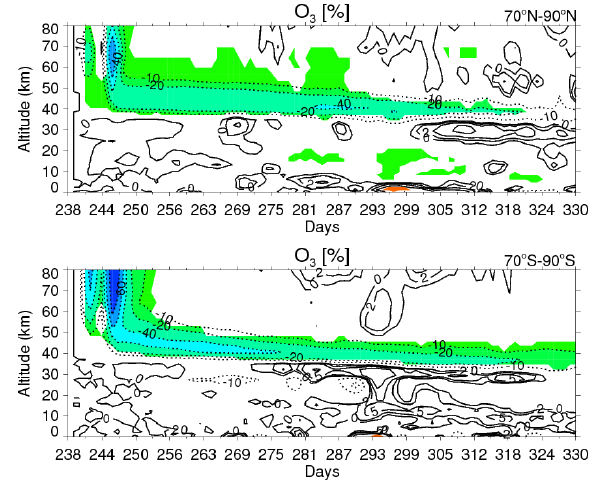
444 Fig. 4: Upper panel : Evolution of changes in ozone zonal mean mixing ratio profile in the polar 445 Fig. 4. Upper panel: evolution of changes in ozone zonal mean mix- region (70°-90°N) in percent. Lower panel : same for 70°-90°S. Colors indicate areas with at least 446 ing ratio profile in the polar region (70–90 ◦ N) in percent. Lower 95 % statistical significance. Contour levels: -100, -80, -60, -40, -20, -10, 0, 2, 5, 10, 50 %. 447 panel: same for 70–90 ◦ S. Colors indicate areas with at least 95% statistical significance. Contour levels: − 100, − 80, − 60, − 40, − 20, − 10, 0, 2, 5, 10, 50%.